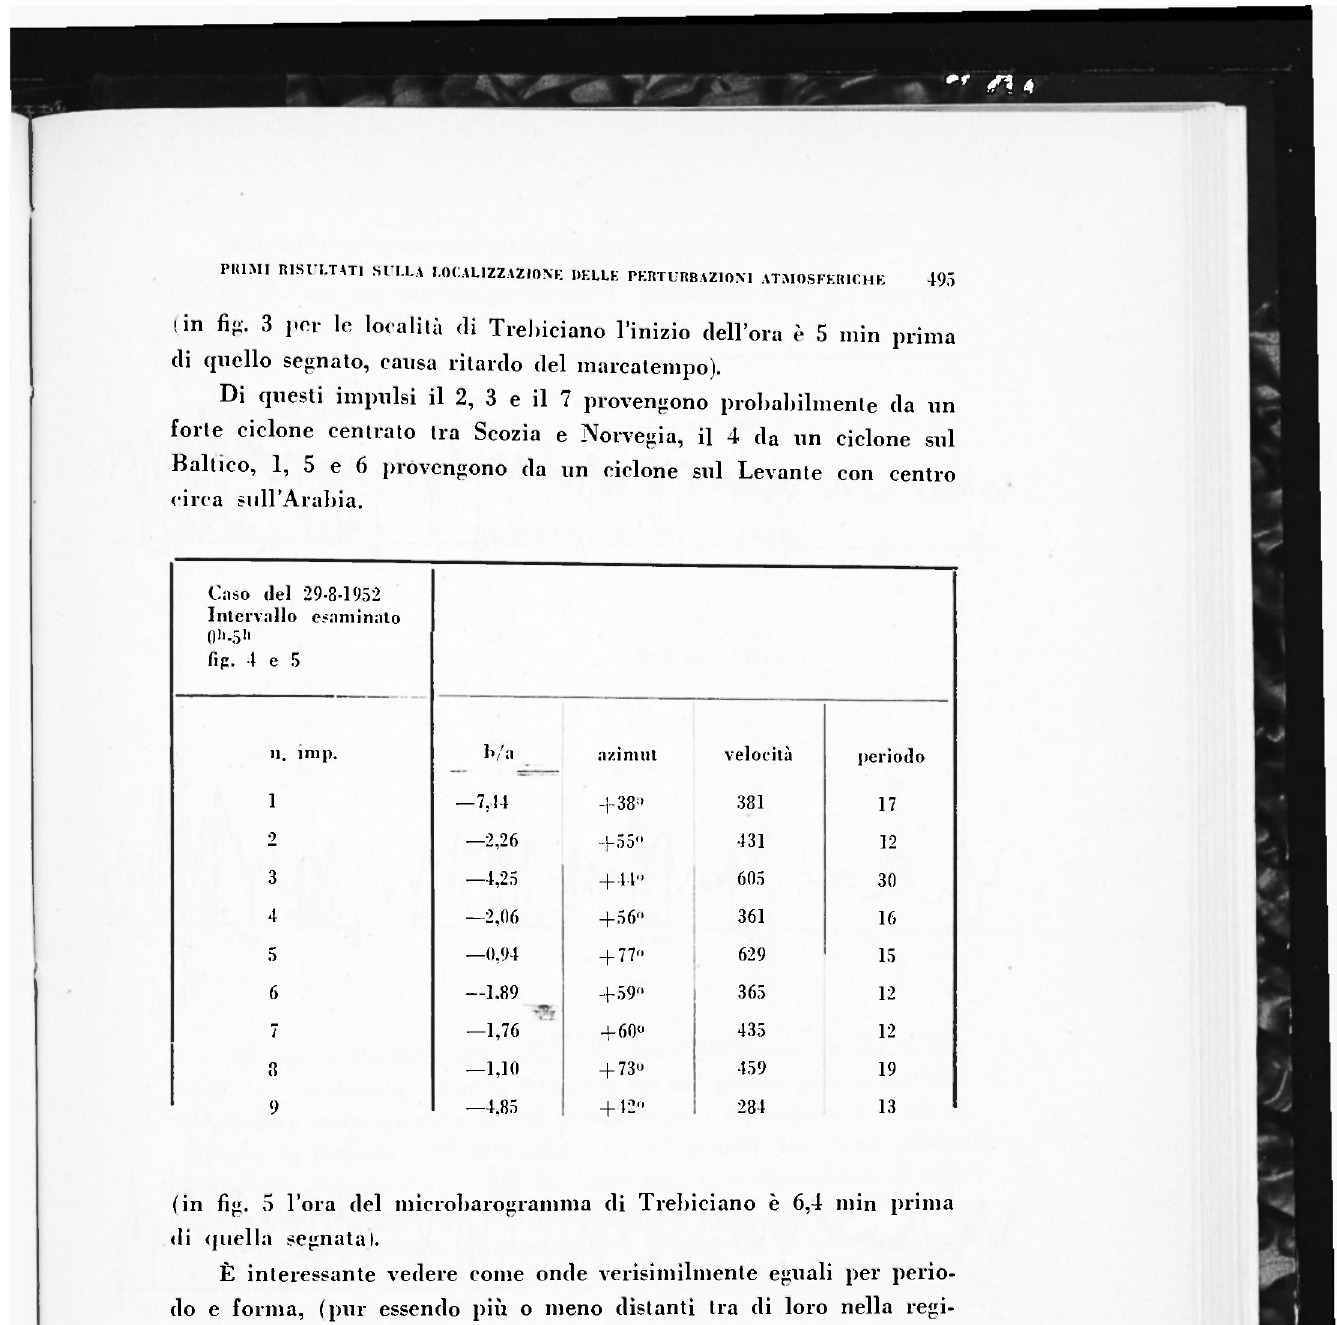
(in fig. 5 l'ora del microbarogramma di Trebiciano è 6,4 min prima di quella